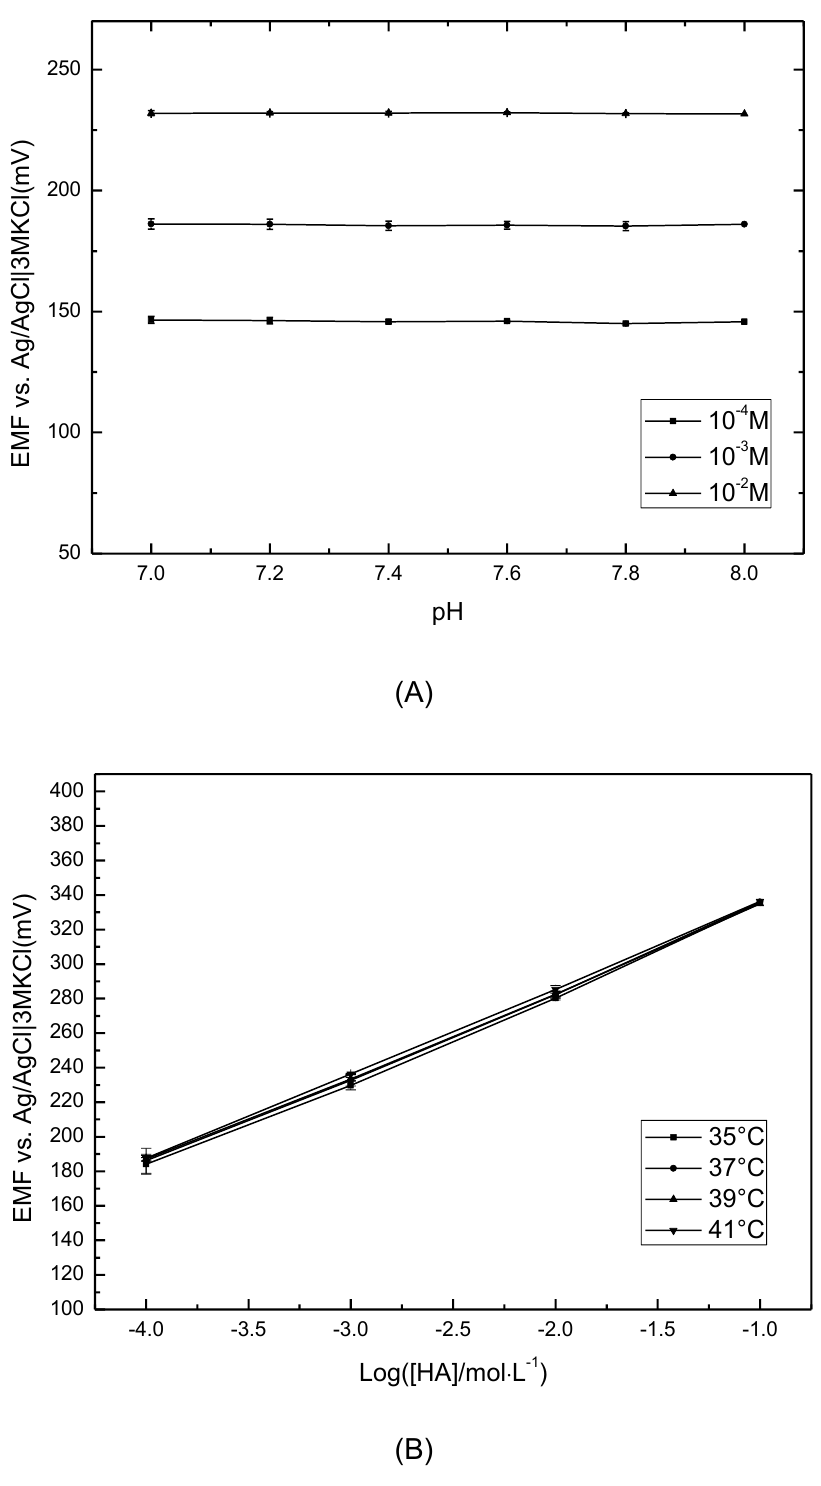
Fig. 3. (A) Effect of pH on the potential response to HA solutions ( 10 −4 M 、 10 −3 M and 10 −2 M ) in the Figure 4. ( A ) Effect of pH on the potentiometric response to histamine solutions (10 − 4 M, 10 − 3 M and 10 − 2 M) with the background of acetic buffer (CH 3 COOH-LiOH); ( B ) Effect of temperature on background of acetate buffer; (B) Effect of temperature on the potential response to HA solutions the potential response to histamine solutions from 10 − 4 to 10 − 1 ( 10 −4 M - 10 −1 M ) in the background of the acetate buffer.